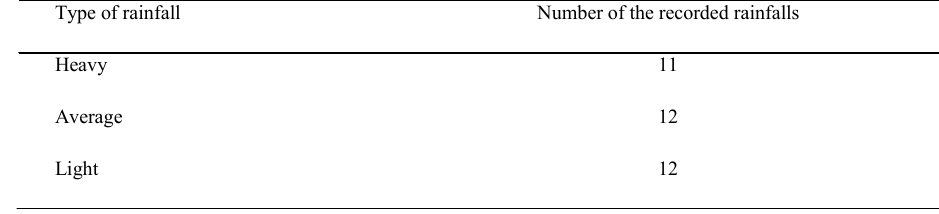
Table 1: Number and amount of the recorded